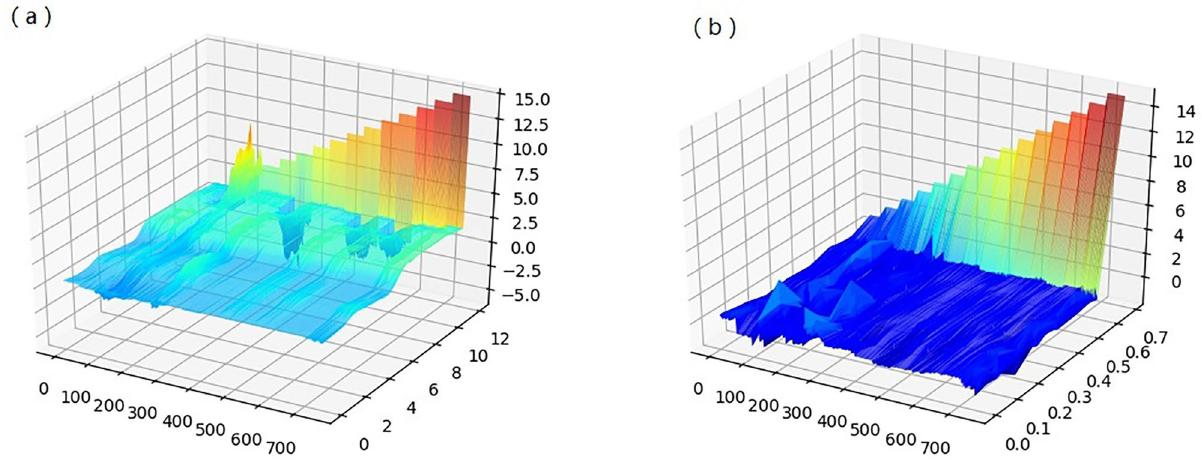
Figure 5. 3D map of spectral feature ( a raw spectrum, b MSM reconstructed spectrum).